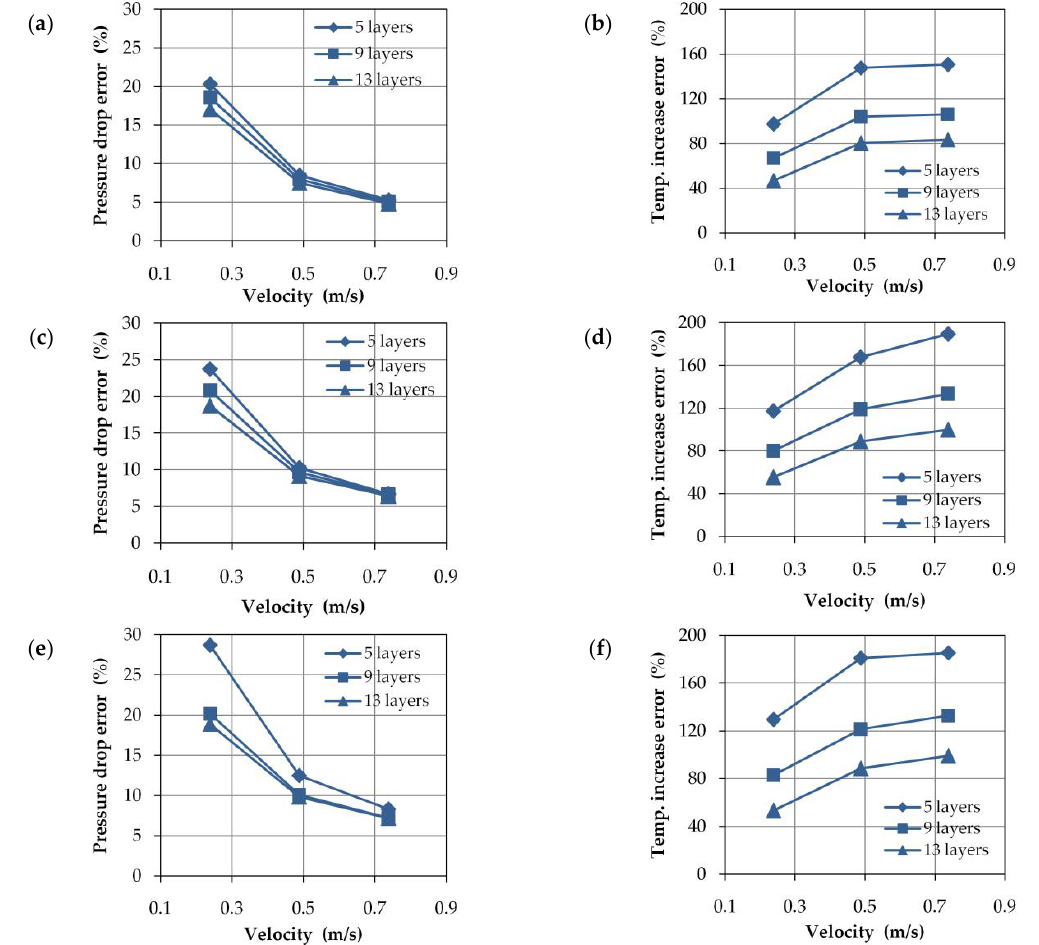
Figure 11. Relative deviations of pressure drop and temperature increase within the reactor bed between full and simplified model: ( a , b ) 2-mm spheres, ( c , d ) 3-mm spheres, ( e , f ) 4-mm spheres.